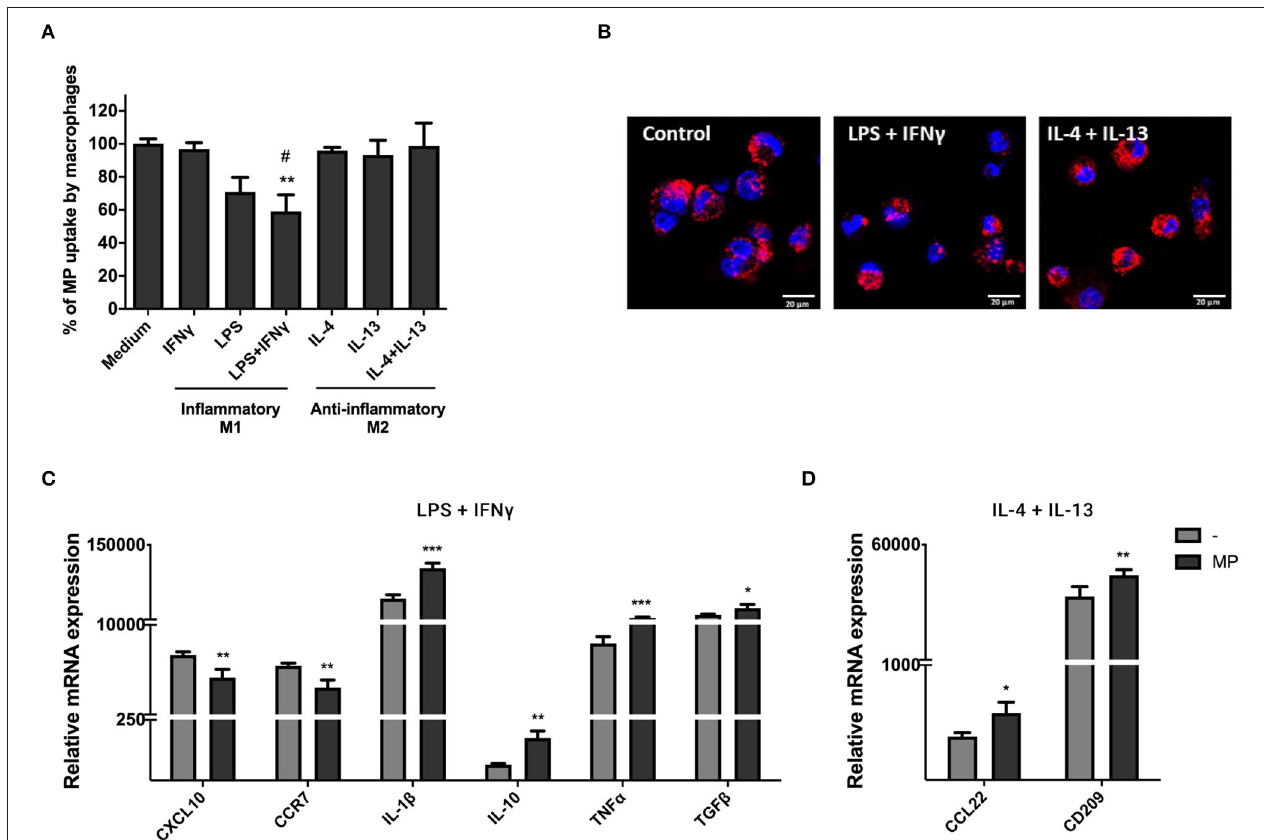
FIGURE 5 | MP uptake under pro- and anti-inflammatory conditions modulates macrophages function. Macrophages were primed with 100ng/ml LPS and 20ng/ml IFN γ (M1 macrophages) or with 20ng/ml IL-4 and 20ng/ml IL-13 (M2 macrophages). (A,B) PKH-MP were added to macrophages (ratio 1:50,000) and incubated for 24h for uptake analyze by flow cytometer and confocal microscopy. (A) Percentage of macrophages positive for PKH-MP in different culture conditions. (B) Representative confocal microscopy analysis of MP uptake by macrophages under stimulation of IFN γ + LPS or IL-4 + IL-13. (C,D) Macrophages were separated from MP and assessed by real-time RT-PCR after 48h. mRNA expression of macrophages treated with MP in the presence of (C) LPS + IFN γ (CXCL10, CCR7, IL-1, IL-10, TNF α , and TGF β ) and (D) IL-4 + IL-13 (CCL22 and CD209). Data are presented as mean ± SD from 6 experiments. * P < 0.05 , ** P < 0.01 , and *** P < 0.001 vs. medium control or vs. macrophages without MP and # P < 0.05 vs. macrophages stimulated with IL-4 + Il-13. Scale bar: 20 µ